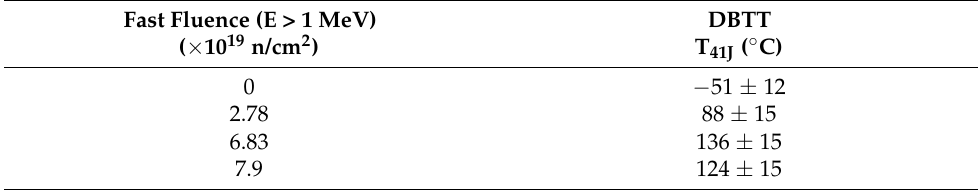
Table 4. Fast fluence (E > 1MeV) and DBTT for 15Kh2NMFA material.